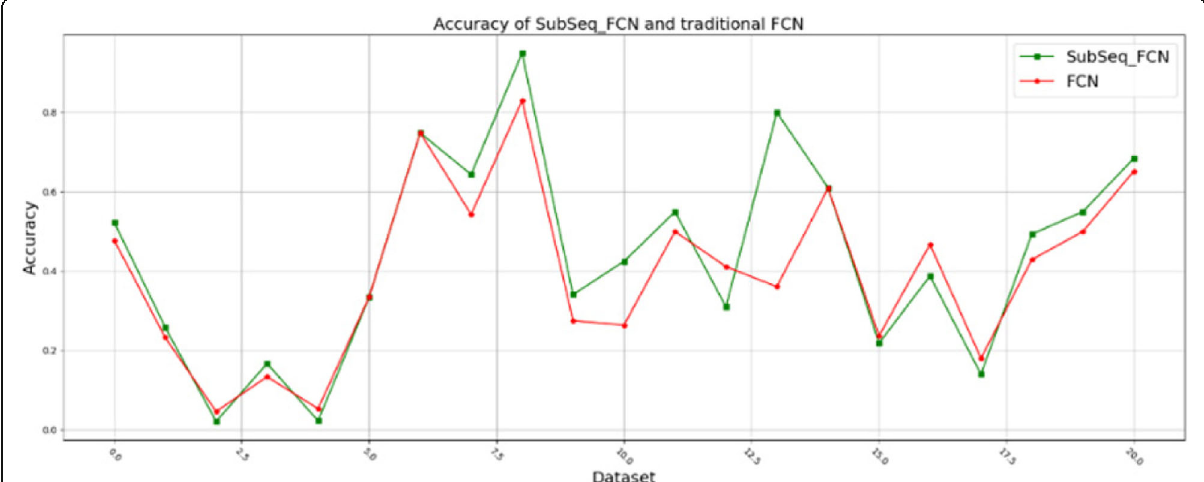
Fig. 13 Accuracy of SubSeq_FCN and traditional FCN